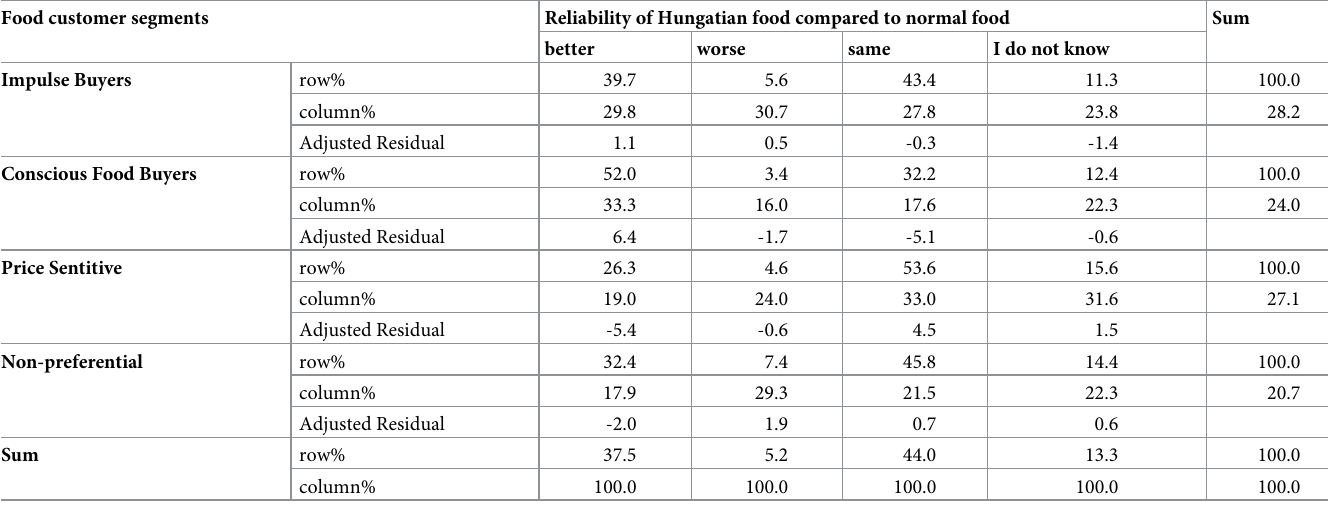
Table 5. Opinions of food customer segments on the reliability of Hungarian food. Food customer segments